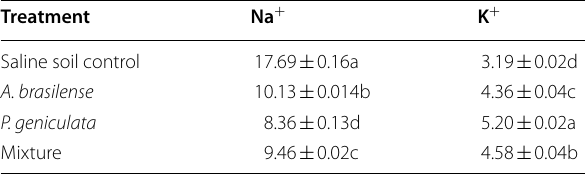
Table 2 Effect of the inoculation with Azospirillum brasilense , Pseudomonas geniculata individually or co-inoculation on sodium (Na + ) and potassium (K + ) content (mg g − 1 DW) of flax plants ( Linum usitatissimum ) grown in saline soil